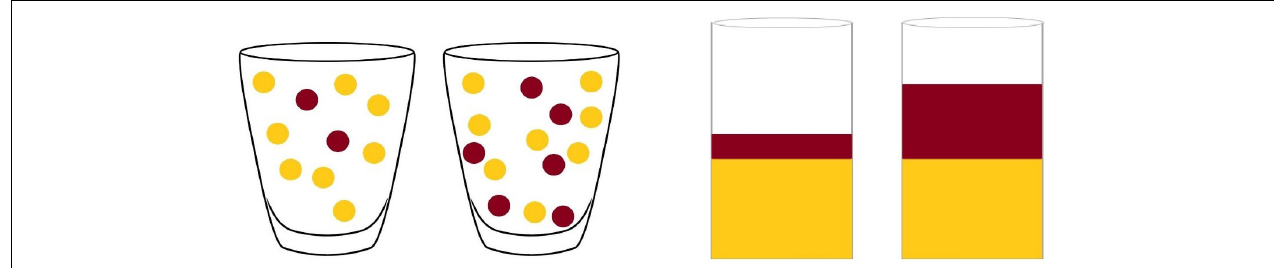
FIGURE 2 | Illustration of one trial in the discrete (left) and continuous ratio reasoning